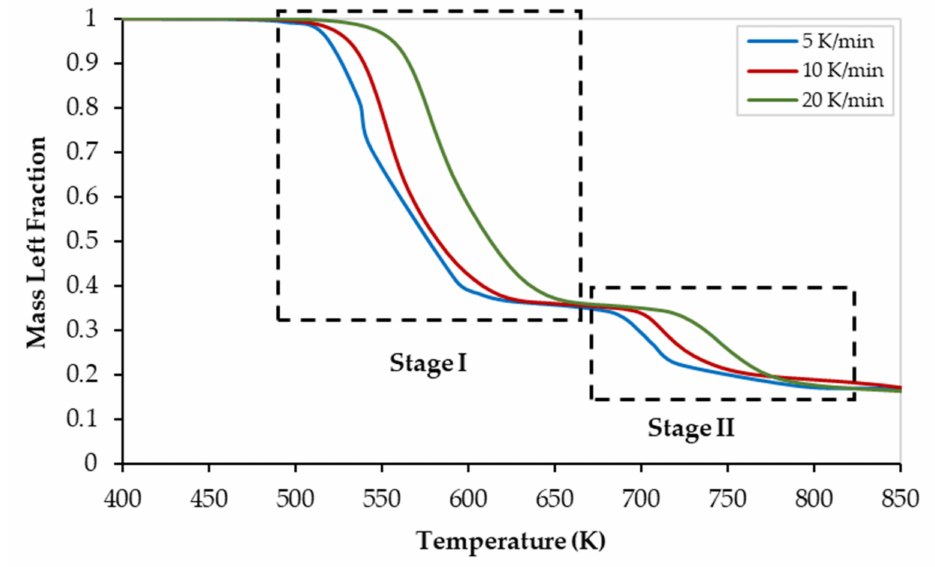
Figure 1. Thermogravimetric (TG) curves of the PVC pyrolysis at different heating